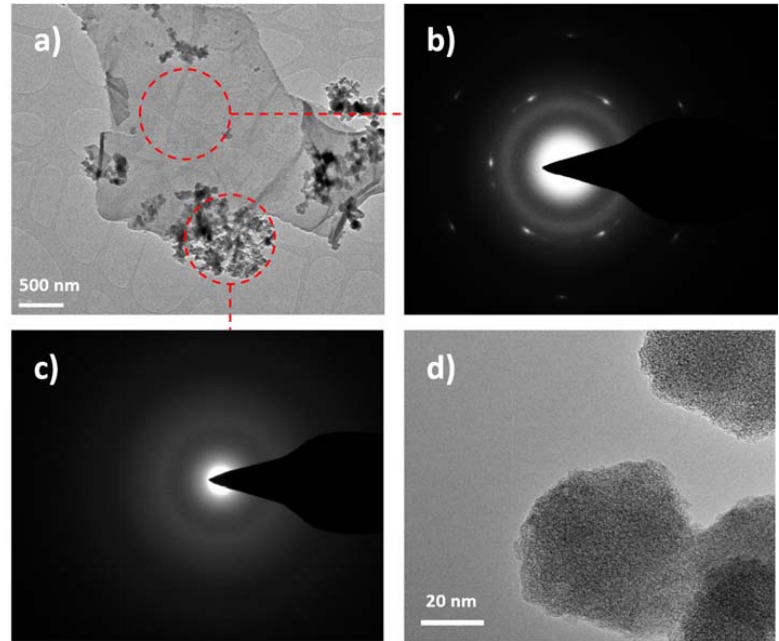
Figure 3. ( a ) low ‐ magnification Bright Field TEM image of RGO flake decorated with Ruthenium active species nanoparticles. SAED pattern of RGO flake ( b ) and Ruthenium active species nanoparticles ( c ); High Resolution TEM image of Ruthenium active species nanoparticle.( d )